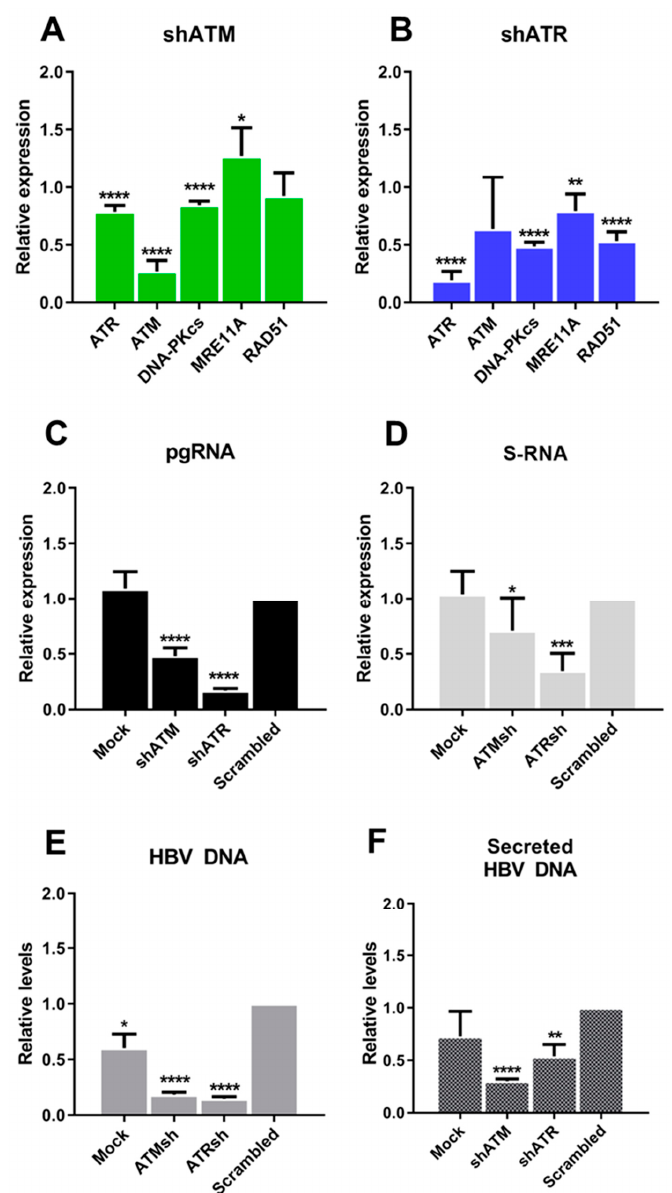
Figure 4. Suppression of HBV replication by ATM and ATR knockdown. Alterations in the transcription of DDR factors in HepG2-1.1merHBV cells transfected with ( A ) shRNA against ATM and ( B ) shRNA against ATR. Knocking down ATM (shATM) and ATR (shATR) reduces ( C ) HBV pgRNA, ( D ) HBV S-RNA, ( E ) intracellular HBV DNA levels and ( F ) secreted HBV DNA levels. The results were reproduced in at least 3 independent experiments. Asterisks indicate statistically significant di ff erences in means compared to control. * p < 0.05, ** p < 0.01, *** p < 0.001, **** p <